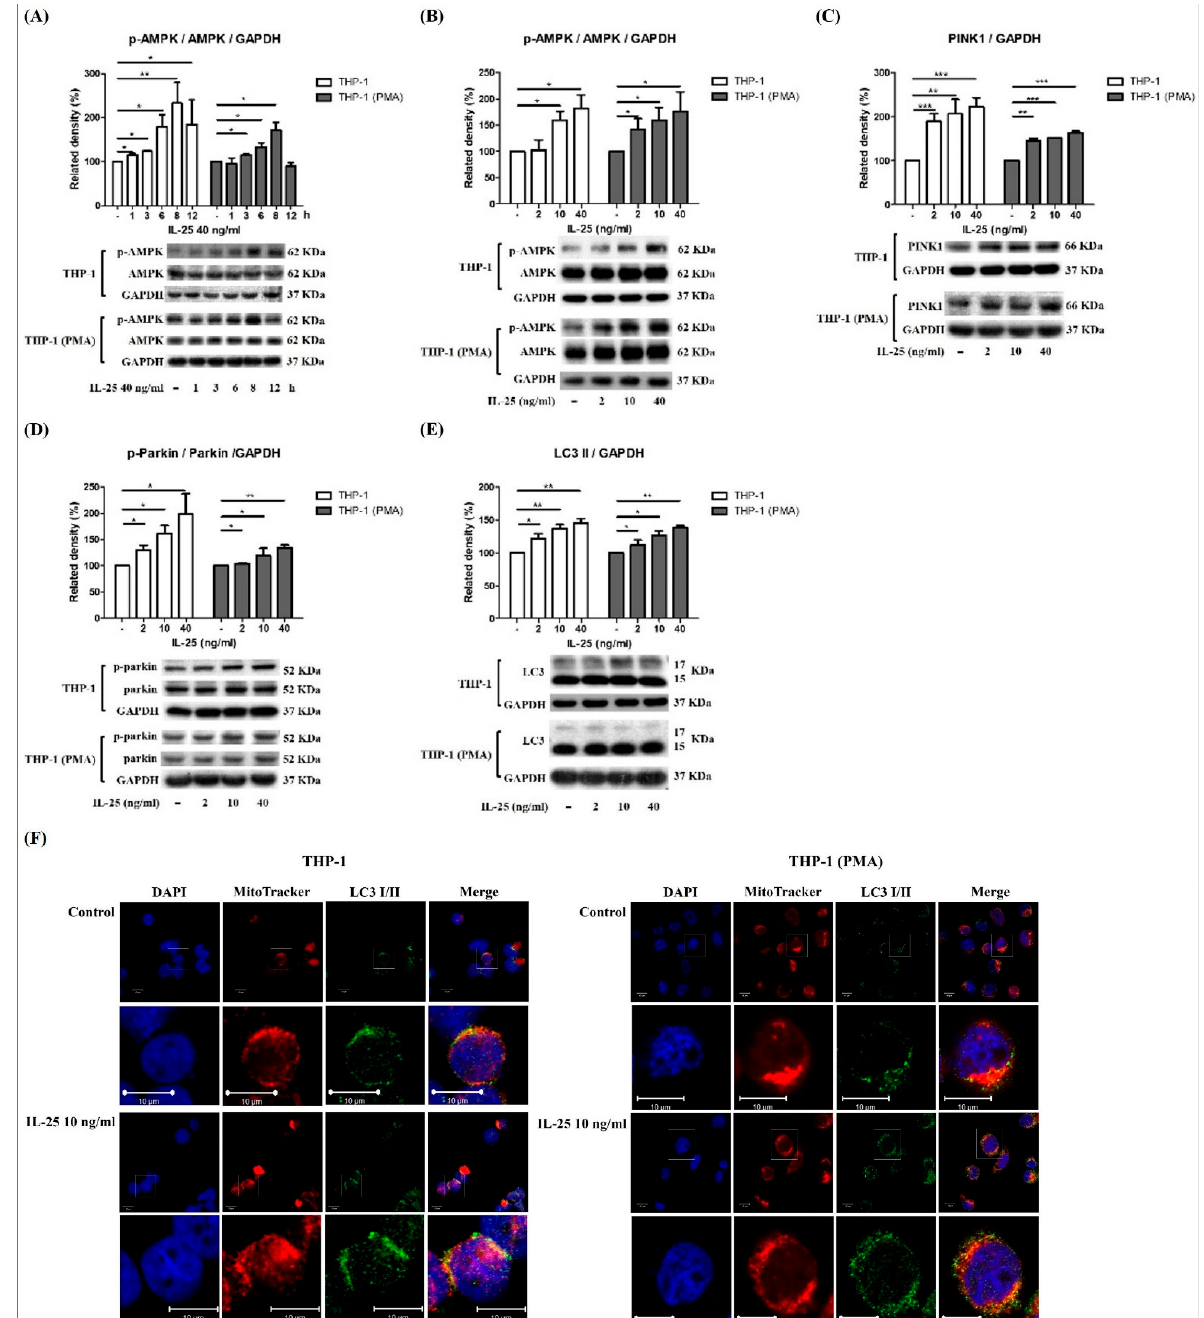
Figure 3. IL-25-induced AMPK activation and mitophagy-related proteins expression in THP-1 cells and THP-1 derived macrophages. ( A ) The time course of p-AMPK expression was determined at 1, 3, 6, 8, and 12 h with IL-25 (40 ng/mL) or medium alone treatment in THP-1 cells (white bar) and THP-1 derived macrophages (gray bar). Data present the means ± SD of 3 independent experiments. The expression of p-AMPK ( B ), PINK1 ( C ), p-parkin ( D ), and LC3 ( E ) by medium alone or IL-25 (2, 10, and 40 ng/mL) treatment in THP-1 cells (white bar) and THP-1 derived macrophages (gray bar) at 8 h time point were determined by western blot. * p < 0.05, ** p < 0.01, and *** p < 0.001; n = 3, means ± SD. The confocal data show the nuclear (DAPI), mitochondria (MitoTracker), and LC3 I/II fluorescence images by medium alone or IL-25 (10 ng/mL) treatment ( F ). Scale bars = 10 µ m in